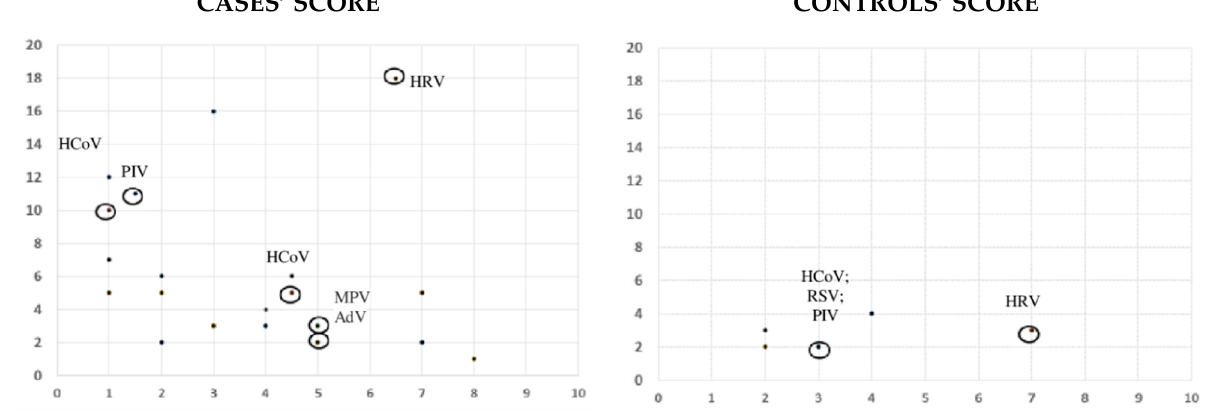
Figure 1. Case and control scores during symptomatic episodes; symptomatic episodes in which a virus was detected have been indicated with a circle. AdV: adenovirus; HCoV: human coronavirus; HRV: rhinovirus; MPV: metapneumovirus; PIV: parainfluenza virus; RSV: respiratory syncytial virus.